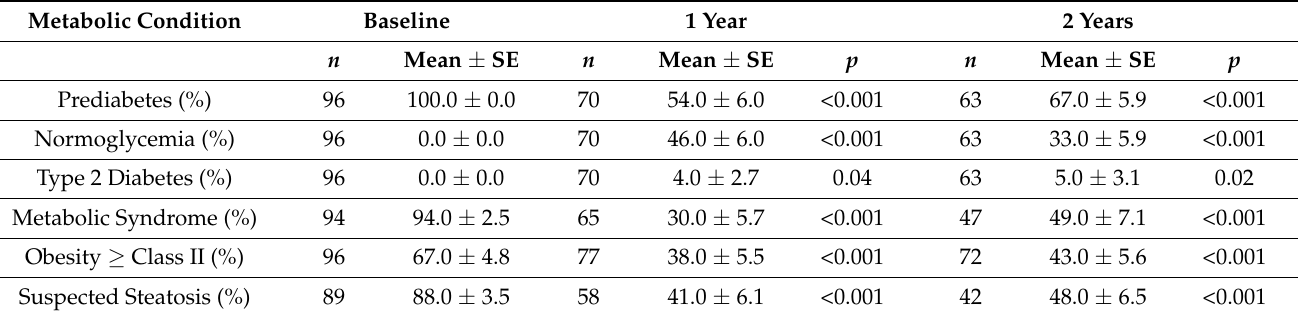
Table 1. Prevalence of metabolic condition status over two